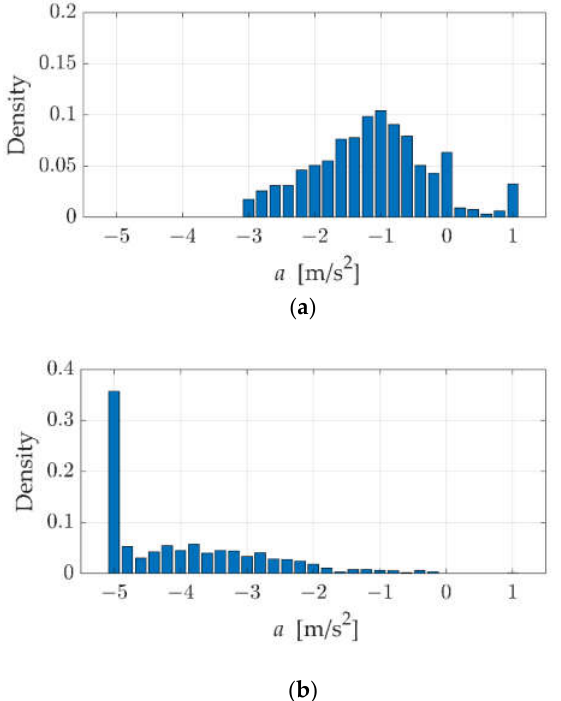
Figure 11. Histogram of acceleration usage. ( a ) Proposed, ( b ) base.